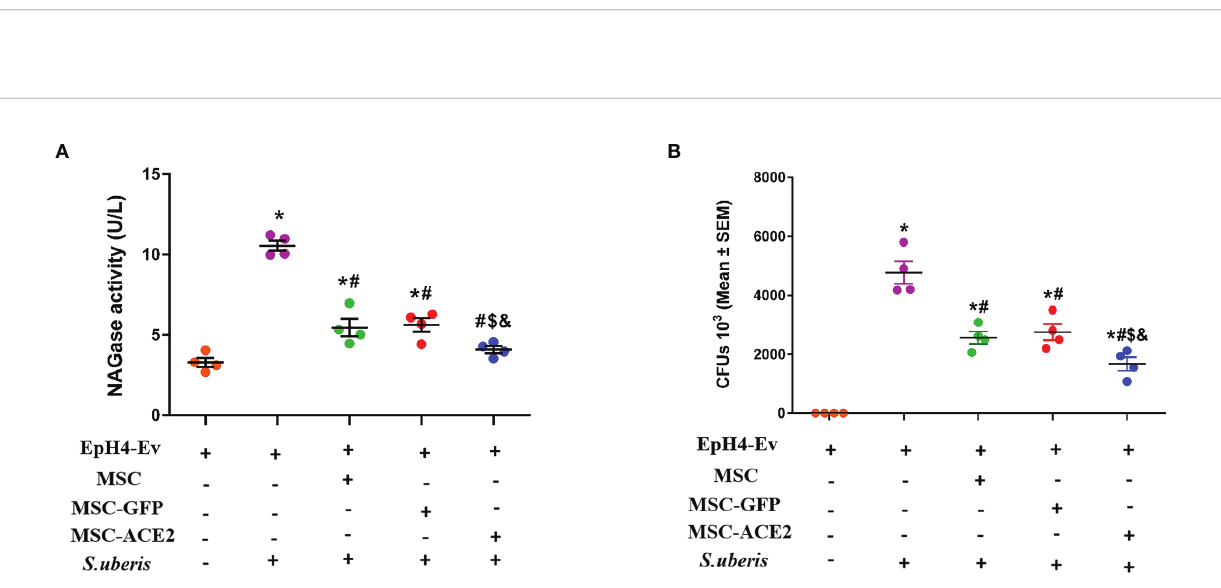
FIGURE 1 | Effect of MSC-ACE2 on the secretion level of in fl ammatory mediators in EpH4-Ev cells. (A-C) Detection of relative transcript levels of TNF- a , IL-1 b , and IL-6 in EpH4-Ev cells by qPCR. TNF- a , tumor necrosis factor- a ; IL-I b , interleukin-I b ; IL-6, interleukin-6. (D-F) Detection of TNF- a , IL-1 b , and IL-6 concentration in cell culture supernatants by ELISA. Experiments were repeated three times and data were presented as the mean ± SEM (n = 4). * P < 0.05 vs. EpH4-Ev; # P < 0.05 vs. S. uberis ; $ P < 0.05 vs. MSC; & P < 0.05 vs.